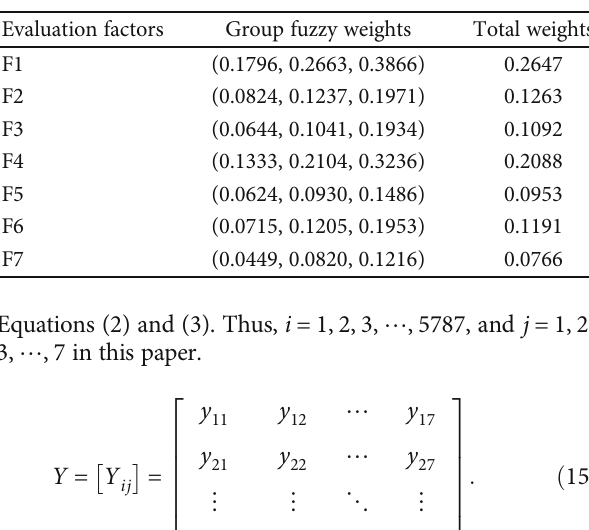
Table 3: Calculated group fuzzy weights and total weights by the